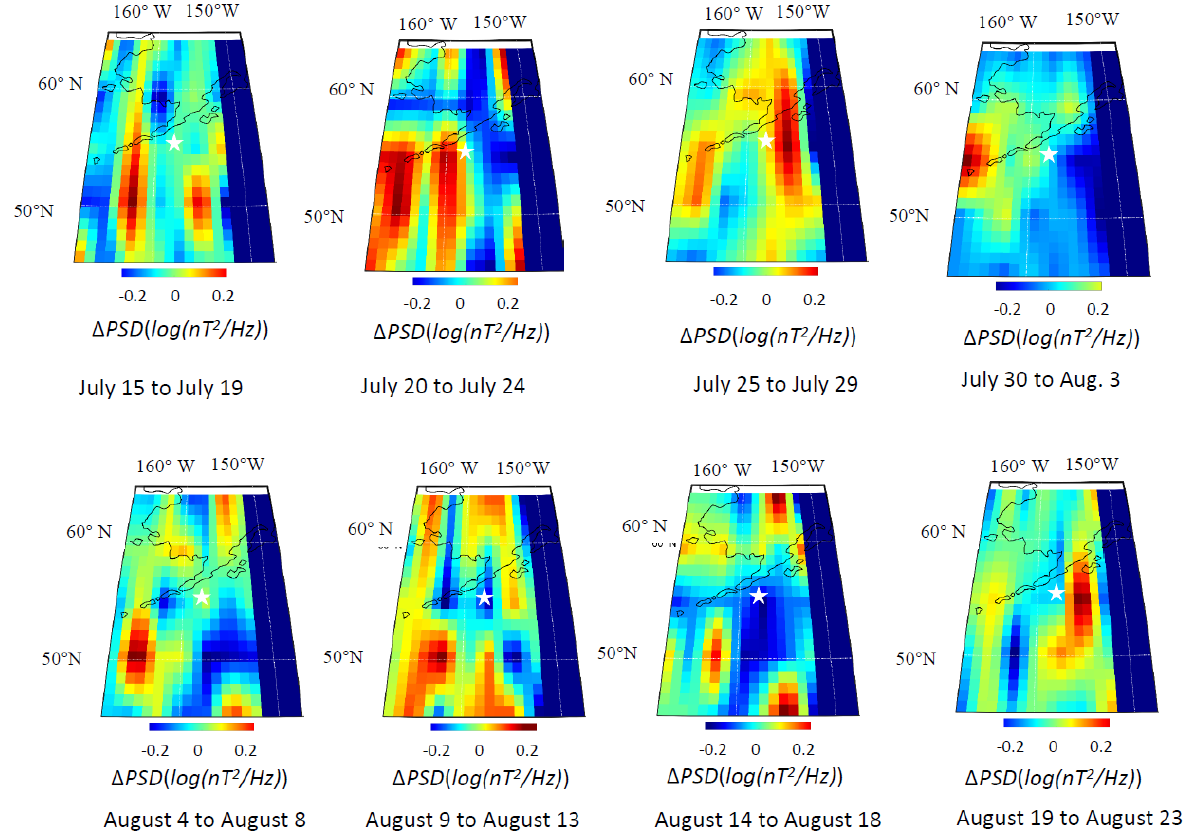
Figure 6. The magnetic field disturbances in frequency from 60 to 73 Hz relative to the background map revealed by the PSD values of the variant magnetic field recorded by SCM during the 29 July 2021 M 8.1 and August 14 M 7.0 Alaska EQs. The star denotes the epicenter